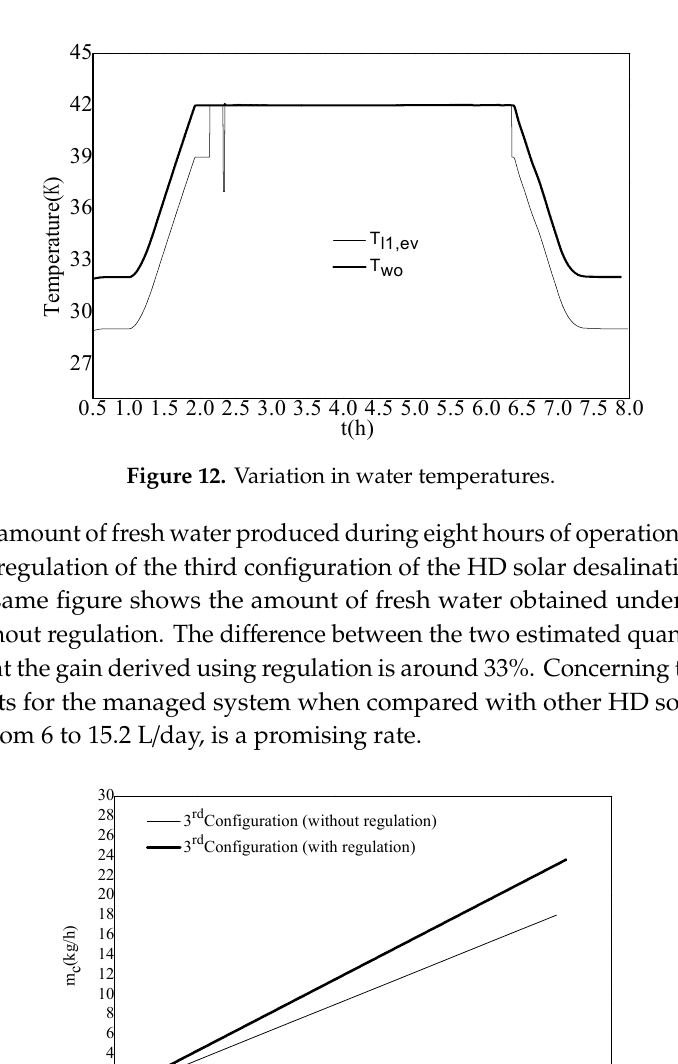
Figure 13. Quantity of distilled water with and without regulation.